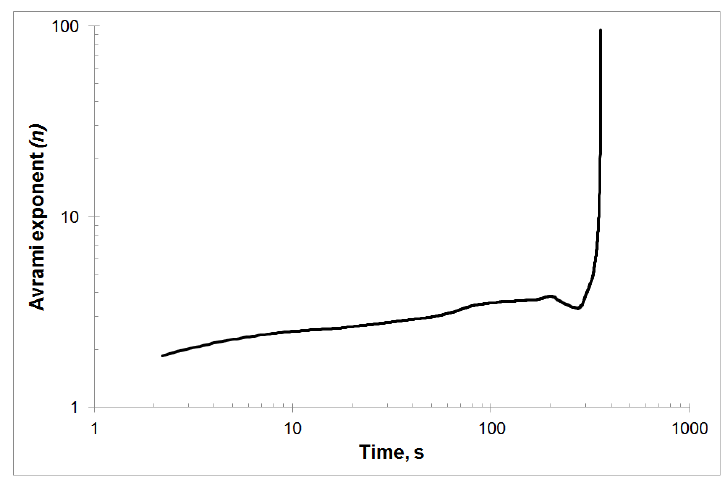
Figure 3. The Avrami exponent n ( t ) varied with time t for isothermal annealing temperature equal to 507 K.